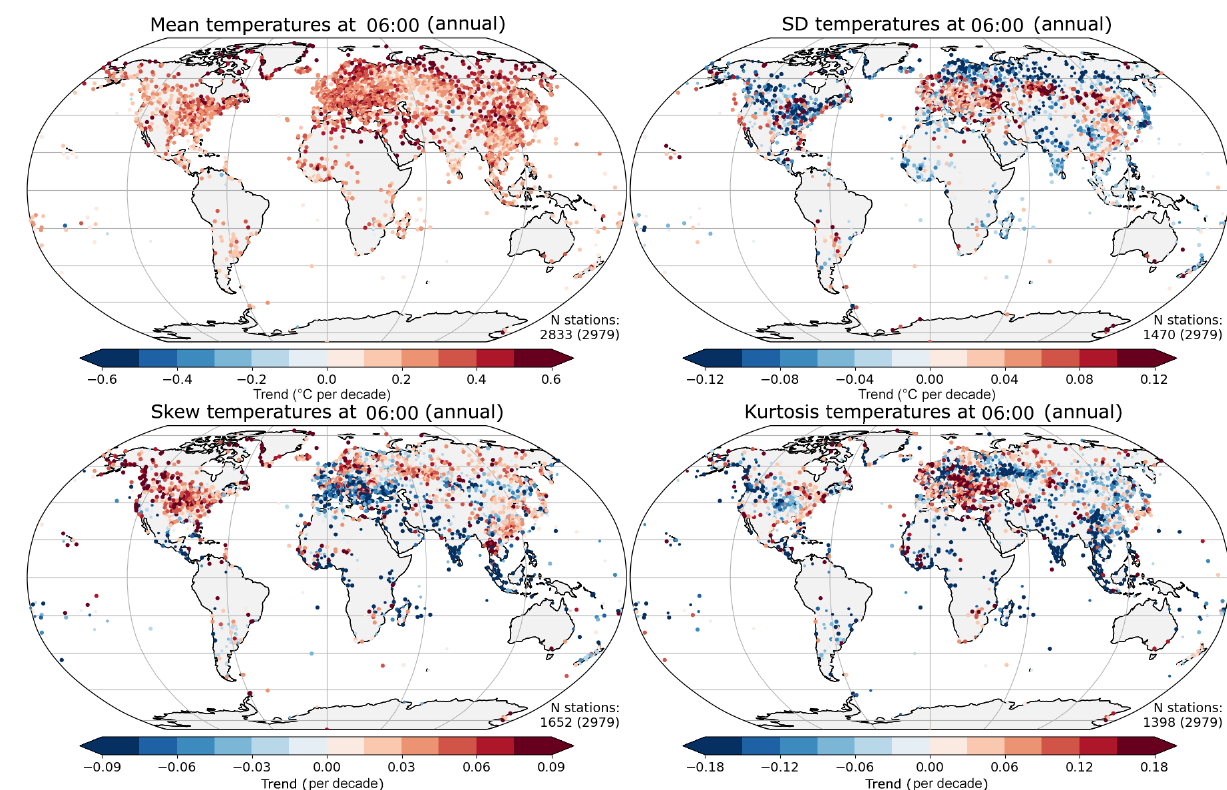
Figure 4. Trend over 1974–2018 in distribution parameters for temperature at 06:00LT, showing the mean ( ◦ C), standard deviation ( ◦ C), skew and kurtosis. The stations where the 1 ˆ σ range of the fitted trend excludes zero are plotted with a larger symbol (the number of these is shown in the bottom right-hand corner of each plot). The total number of stations available is shown in